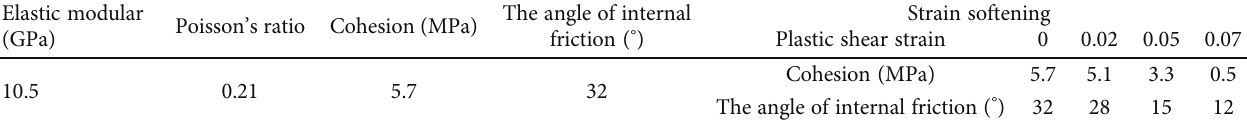
Table 1: The values of parameters used in the calculation.